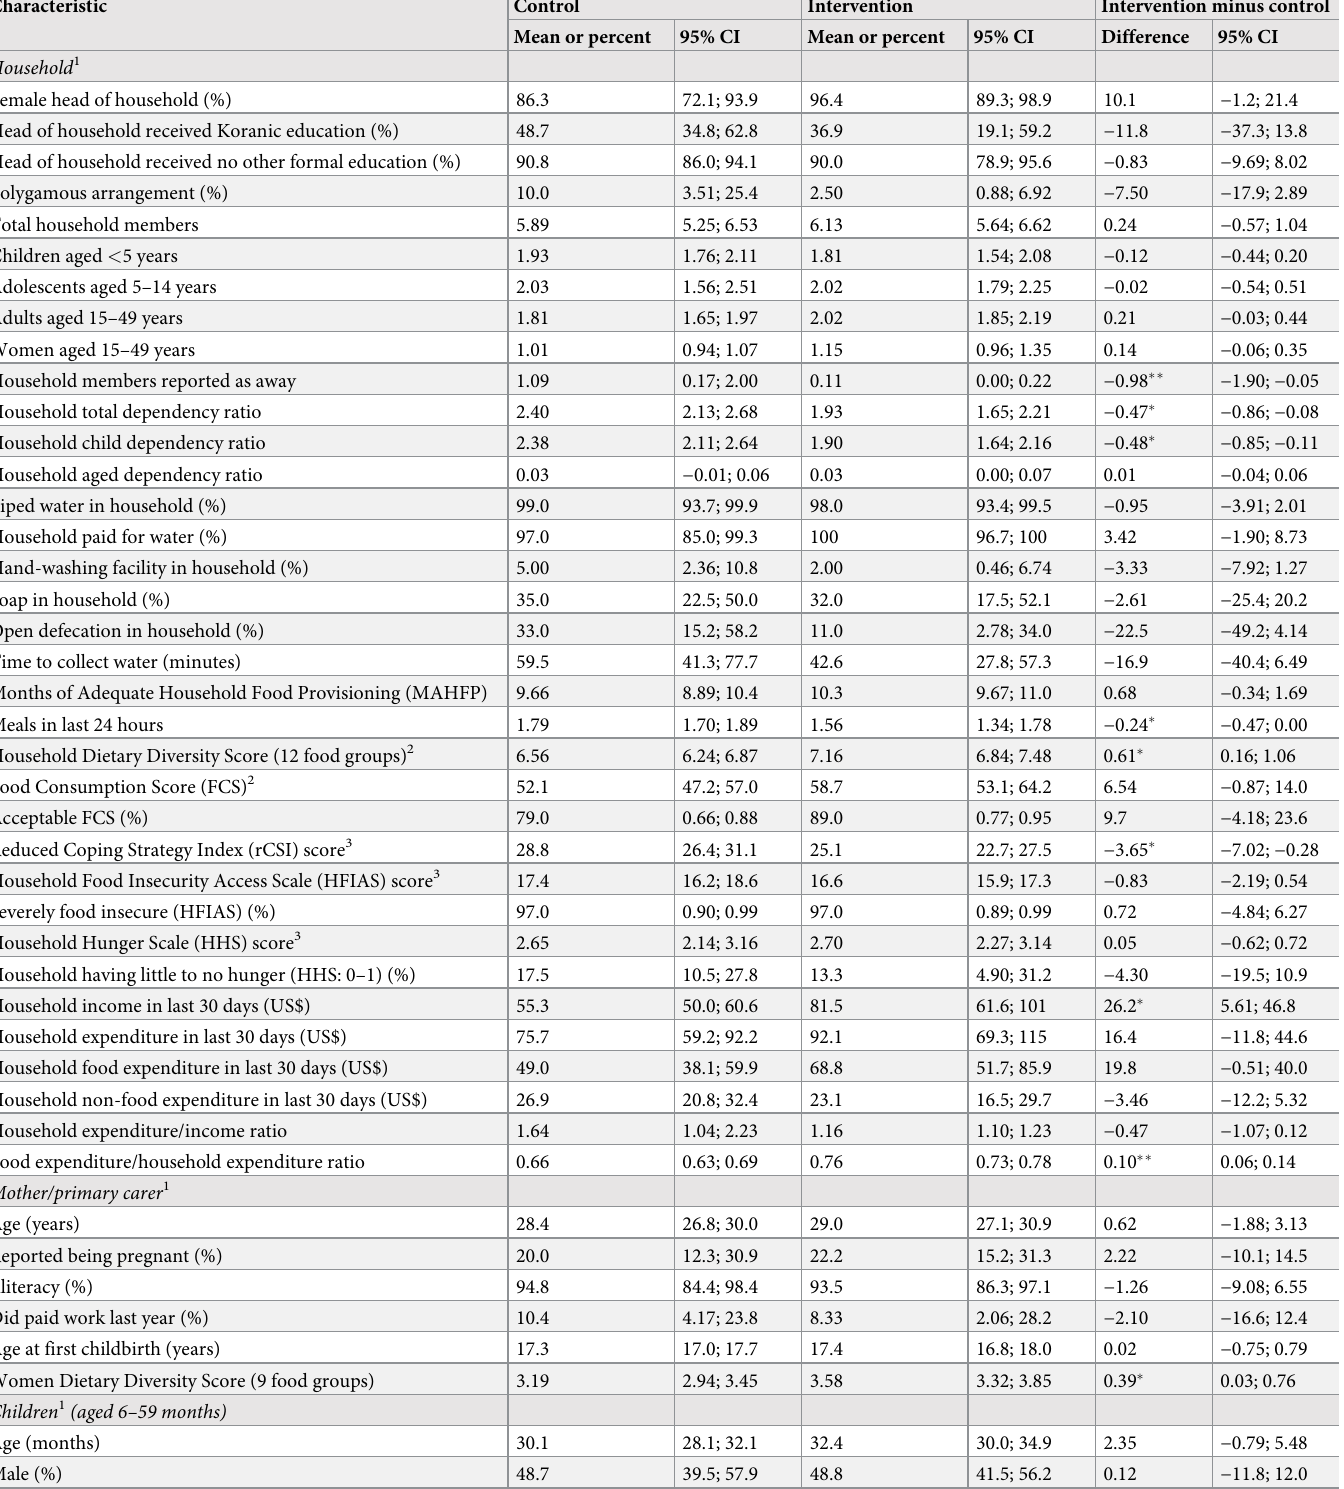
Table 1. Baseline characteristics of the household